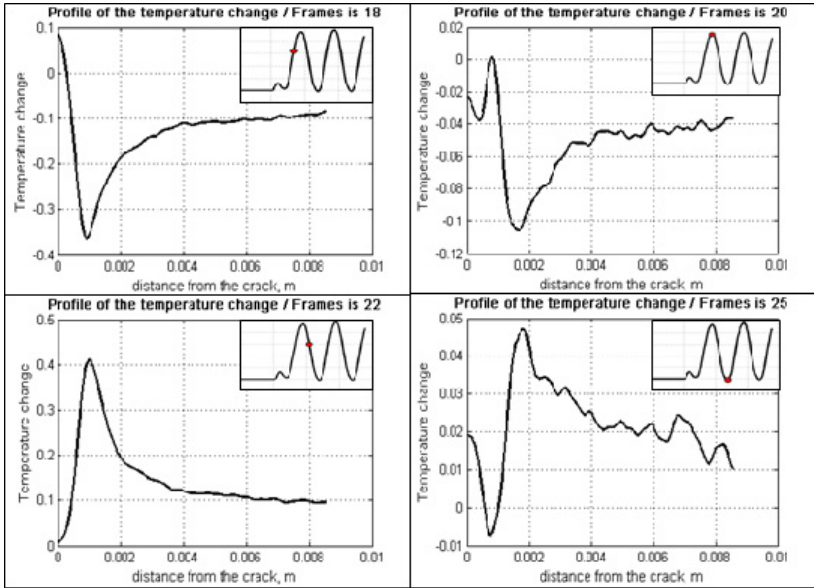
Figure 7: Evolution of temperature distribution in the direction of crack propagation versus applied